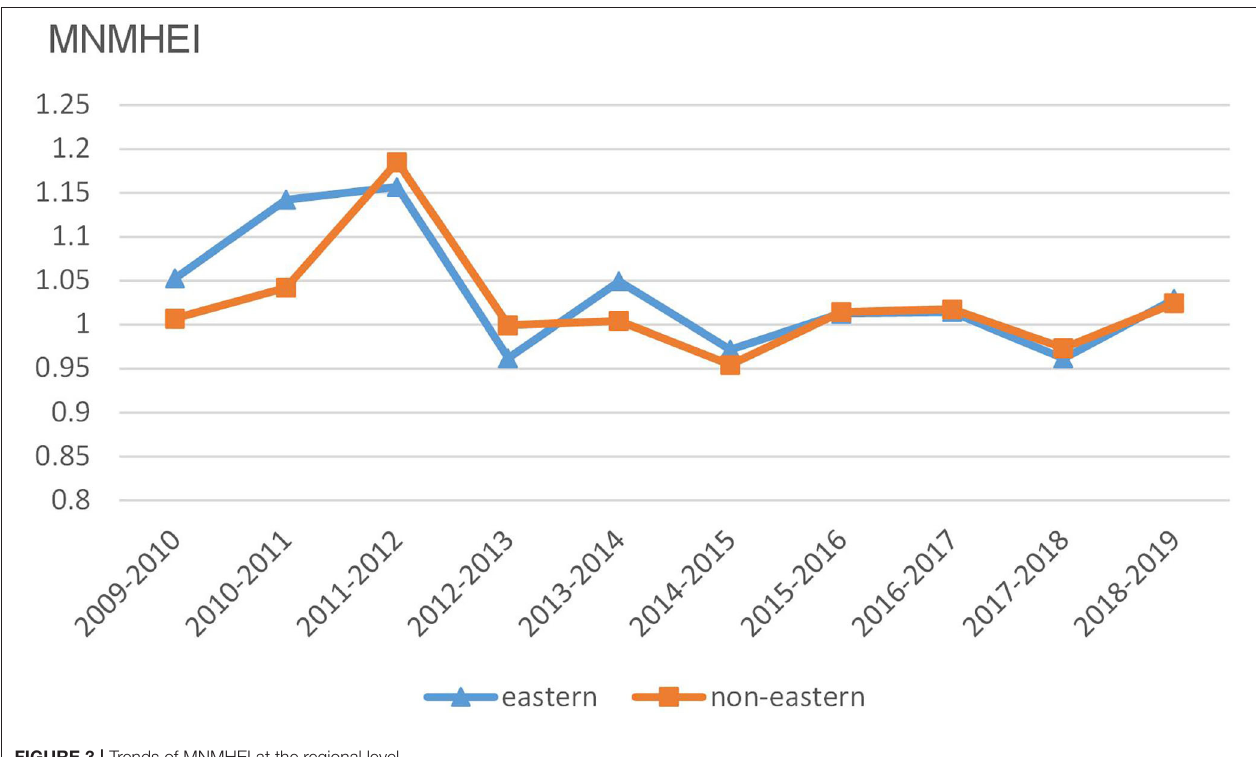
FIGURE 3 | Trends of MNMHEI at the regional level.